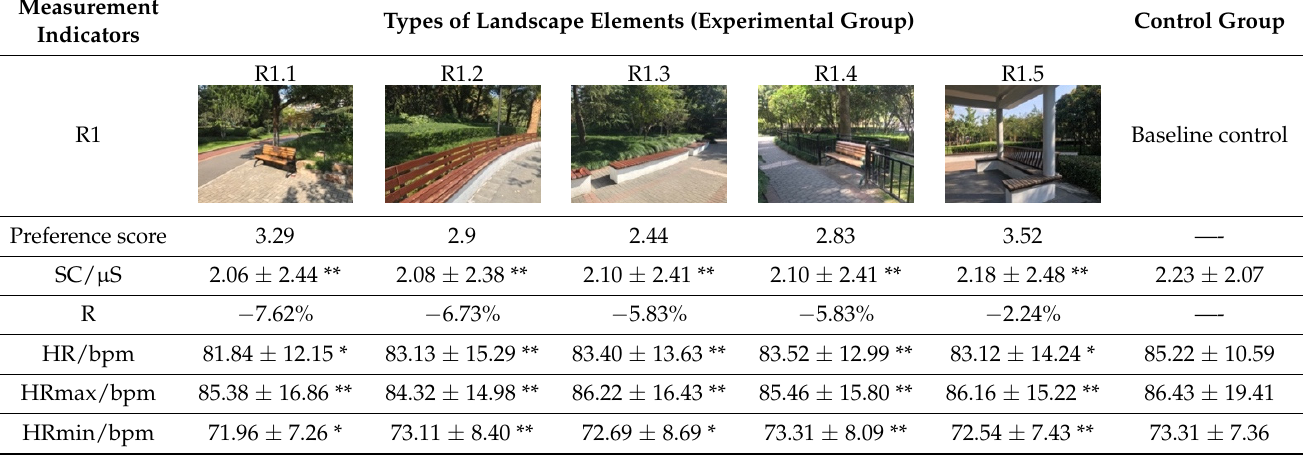
The data in the table are shown as mean ± standard deviation. * Indicates significance at a level of p < 0.05. ** Indicates significance at a level of p < 0.01.